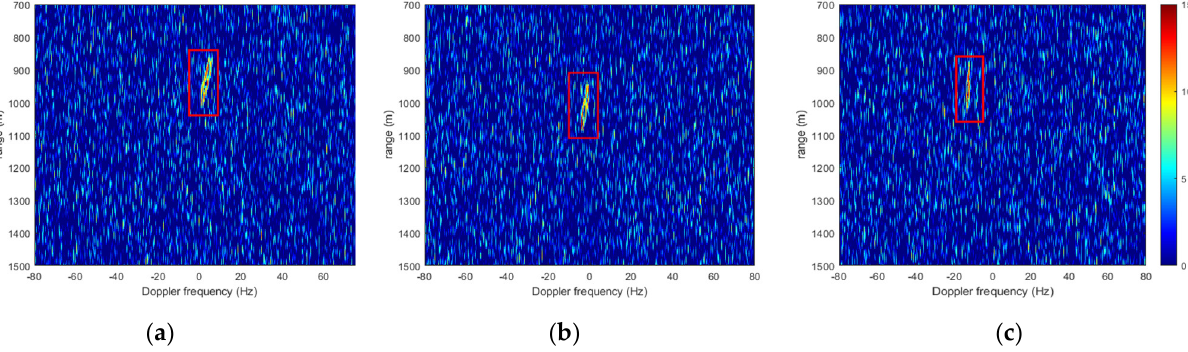
Figure 5. Coherent integration result of a single frame in RD domain: ( a ) first frame, ( b ) central frame, and ( c ) last frame.